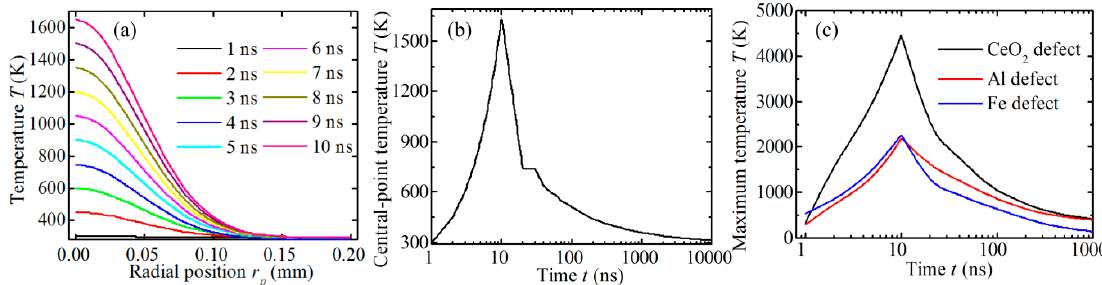
Figure 5. Comparison of temperature distributions caused by fused silica optics with and without impurity defects. ( a ) Temperature variation with respect to the radial position without impurity defect. Evolution of the peak temperature for fused silica optics without ( b ) and with ( c ) impurity defects of CeO 2 , Al and Fe.